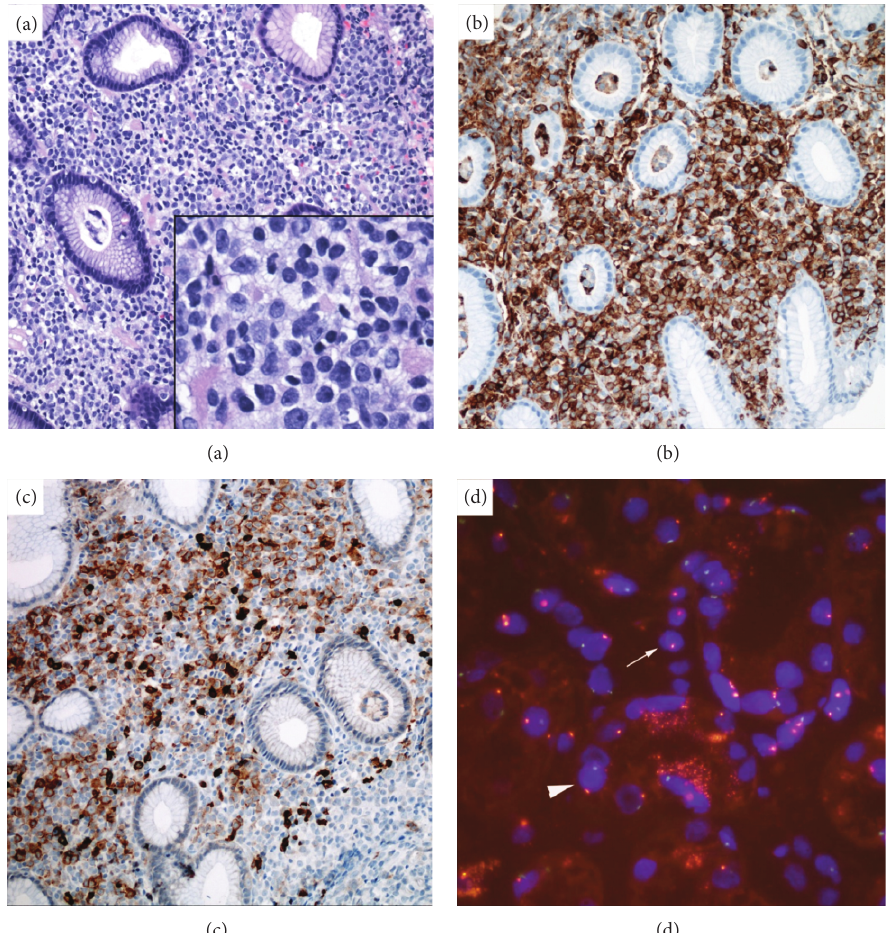
Figure 2: (a) Hematoxylin and eosin stain, showing the gastric biopsy with leukemic infiltrate in the stroma consisting of monomorphous medium sized cells with dispersed but clumped chromatin insinuating in between the normal gastric glands without destruction. Inset shows the high power view (40x magnification) of these leukemic cells. These neoplastic cells express CD34 (b) and CD117 (c). FISH evaluation (d) was performed on this gastric biopsy using X and Y DNA probe set and revealed an XX signal configuration (arrow) in the cells of the leukemic infiltrate which is consistent with female donor chromosome complement and the expected XY configuration (arrowhead) in the gastric tissue consistent with male chromosome complement of this